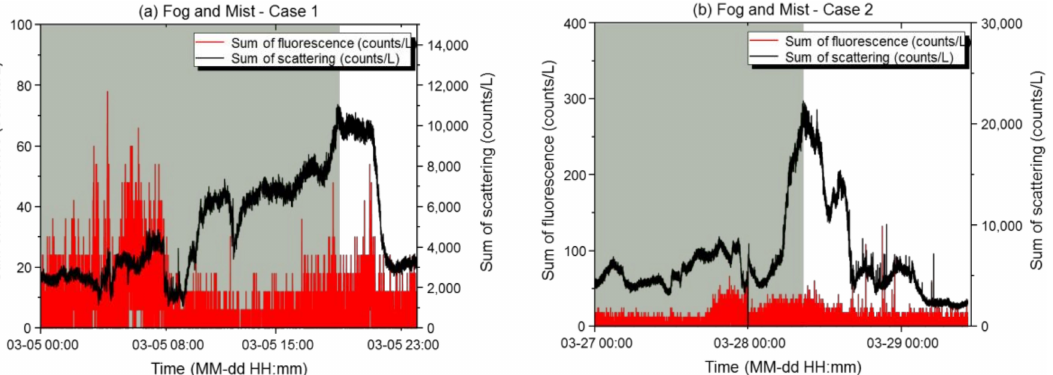
Figure 6. Results of light scattering and fluorescence measurements of the biological particle detector during fog and mist. ( a , b ) Time-dependent concentrations of light scattering and fluorescent particles in Case 1 ( a ) and Case 2 ( b ). The X-axis represents the measurement period, and the Y-axis represents the measured particle concentrations. The black line represents the scattered light sum (counts/L), the red line represents the fluorescence sum (counts/L), and the green line represents the time period when the meteorological condition occurred during the measurement